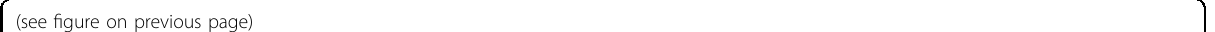
Fig. 1 XPO1 inhibitor KPT-8602 decreases the production of KSHV infectious virions but has no effect on KSHV infectivity, and virus entry and traf fi cking during primary infection. A , B HUVEC were pretreated with the indicated doses of KPT-8602 for 1 h and then infected with KSHV in the presence of KPT-8602. At 4 hpi, cells were extensively washed and replaced with a new medium containing the indicated concentrations of KPT- 8602. At 48 hpi, cells were extensively washed and replaced with a new medium without KPT-8602. Supernatants were collected at 96 hpi and used to titrate infectious virions by infecting fresh HUVEC. At 48 hpi, representative images were taken ( A ) to quantify the number of GFP-positive cells ( B ). C HUVEC pretreated with 0.5 µM KPT-8602 for 1 h were infected with KSHV in the presence of KPT-8602. At 48 hpi, cells were fi xed and stained for LANA (red). The expression level and staining pattern of LANA are shown. Nuclei were stained with DAPI. Images were taken with confocal microscopy (magni fi cation ×600). D Quanti fi cation of LANA-positive cells based on fi ve images taken as described in ( C ). E HUVEC were pretreated with 0.5 µM KPT-8602 for 1 h and then infected with KSHV in the presence of KPT-8602 for the indicated times. Cells were extensively washed and replaced with a new medium without KPT-8602. At 50 hpi, cells were replaced with the new medium. Supernatants were collected at 96 hpi and used to titrate infectious virions by infecting fresh HUVEC. At 48 hpi, GFP-positive cells were quanti fi ed. F HUVEC pretreated with 0.5 µM KPT-8602 for 1 h were infected with KSHV in the presence of KPT-8602 for 6 h, fi xed, and stained for nuclei with DAPI (blue) and KSHV particles with an antibody against ORF65 (red). Images were taken with a confocal microscopy (magni fi cation ×1000). G The total number of KSHV particles successfully docked at the perinuclear region was determined and analyzed based on images taken as described in ( F ). H HUVEC pretreated with 0.5 µM KPT-8602 for 1 h were infected with KSHV in the presence of KPT-8602. Cells were harvested at 6 hpi. Cellular DNA and viral DNA were extracted from whole cells or the nuclear fraction for the detection of the viral genome by qPCR using LANA-speci fi c primers. *, **, and *** indicate P values of <0.05, < 0.01, and <0.001, respectively; NS not signi fi